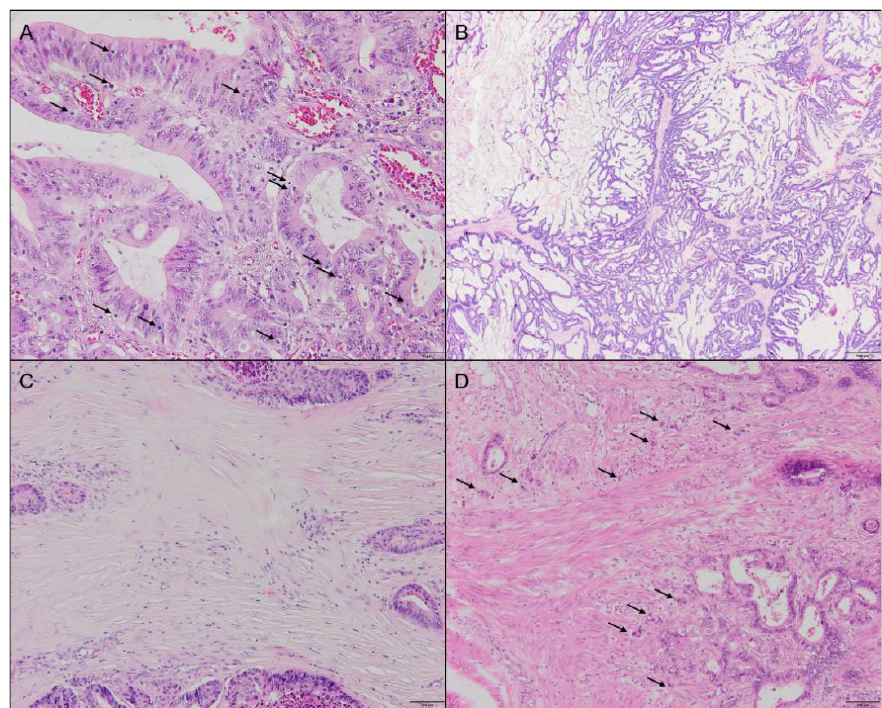
Figure 3. Examples of hematoxylin and eosin-stained sections representative for different histopathologic categories. ( A ) Tumor with high amount of tumor infiltrating lymphocytes, indicated by arrows, 20× objective. ( B ) Mucinous tumor, 2× objective. ( C ) Stroma-high tumor, 10× objective. ( D ) Tumor scored as budding-high, arrows indicate tumor buds, 10× objective.